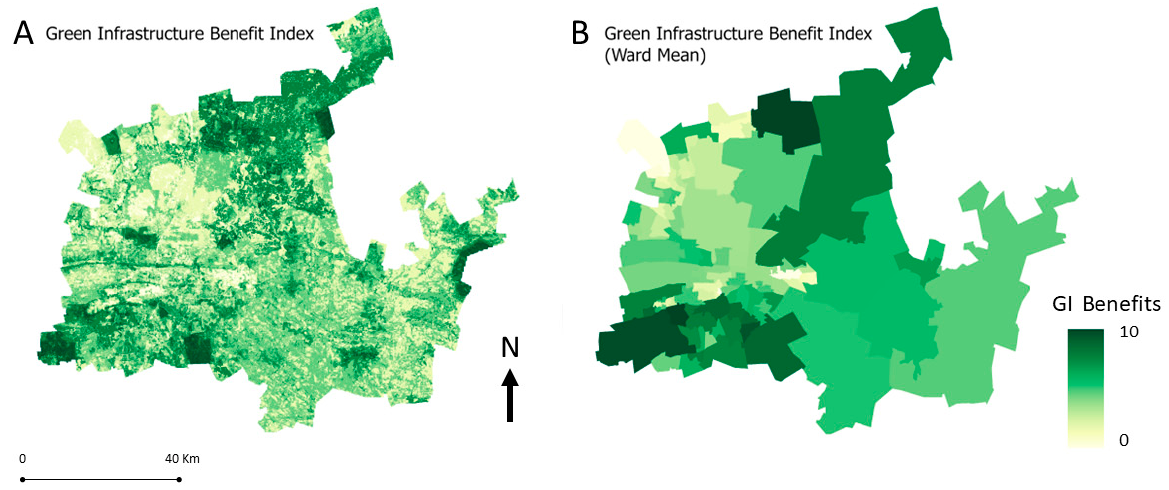
Figure 4. The Green Infrastructure Benefit Index ( A ) shows high levels of green infrastructure benefit provision (dark green) and priority areas for the development of additional green infrastructure projects (light yellow). ( B ) The green infrastructure benefit index is summarized by ward in order to align with municipal budgeting tracts.